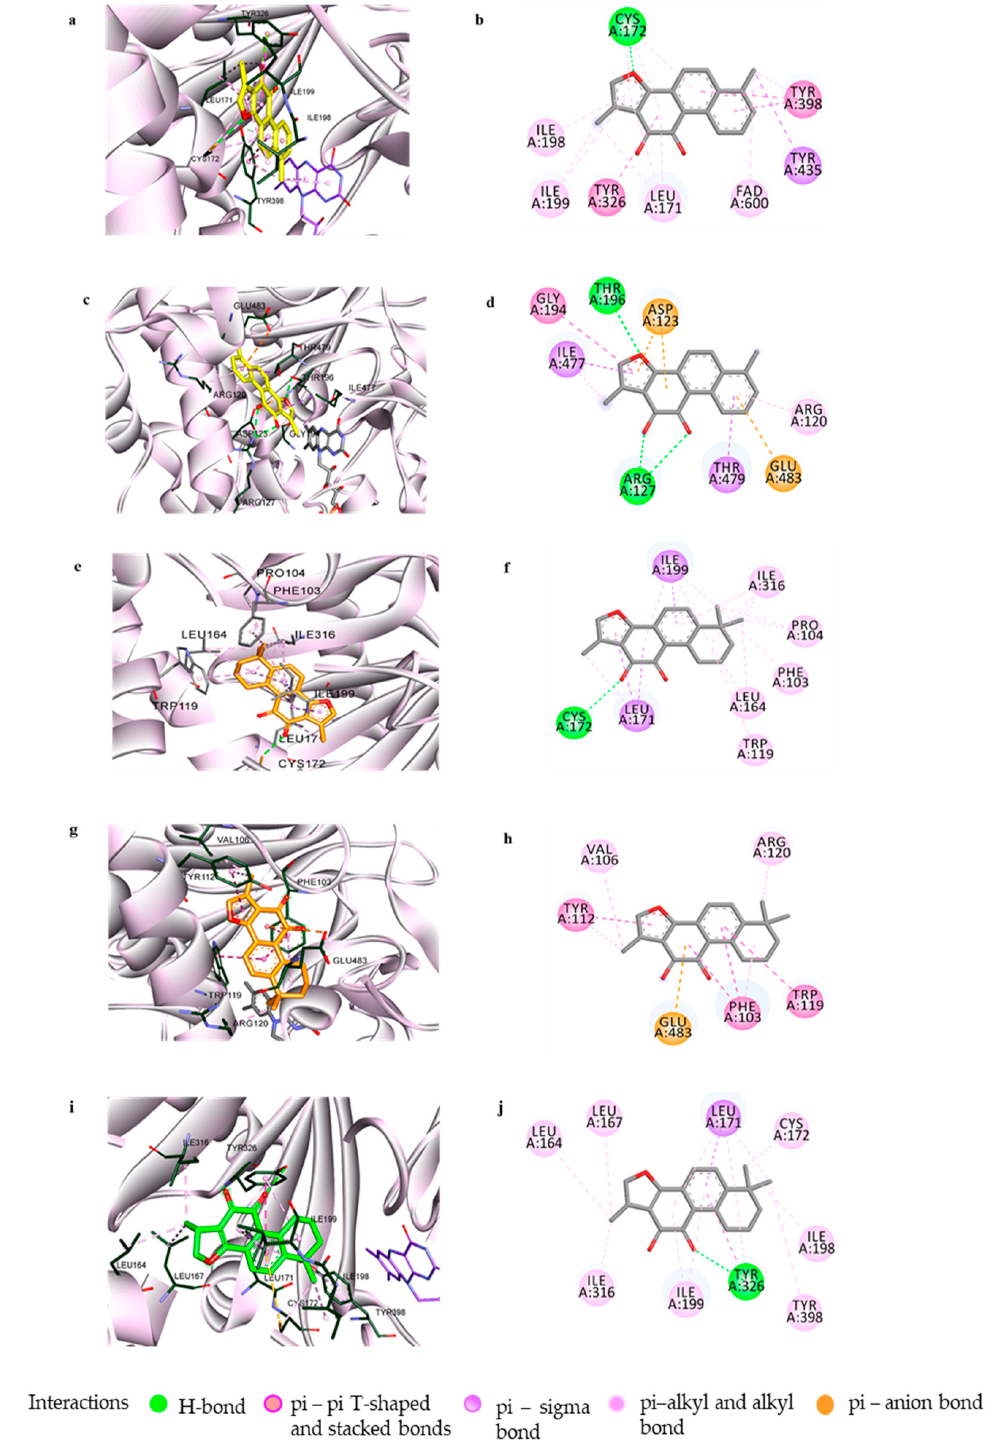
Figure 5. Prediction of the binding modes of the tanshinones with hMAO-B by molecular docking. Close-up view of the compounds tanshinone I (yellow), tanshinone IIA (brown), and cryptotanshinone (green) at the catalytic ( a , e , i ) and allosteric ( c , g ) binding sites of hMAO-B, respectively. 2D-binding diagrams showing the ligand–enzyme interactions for tanshinone I, tanshinone IIA, and cryptotanshinone at the catalytic ( b , f , j ) and allosteric ( d , h ) sites of hMAO-B, respectively. Even though the tanshinones 1 , 2 , and 3 showed their most efficacious activity in As shown in Figure 4, tanshinones 1 , 2 , and 3 occupied the active site of hMAO-A hMAO-A inhibition, these compounds can also suppress hMAO-B significantly, as and interacted with the catalytic binding site with low binding energies of –10.06, –9.91, and –10.07 kcal/mol, respectively. The 1-methylbenzofuran ring of 1 was aligned toward